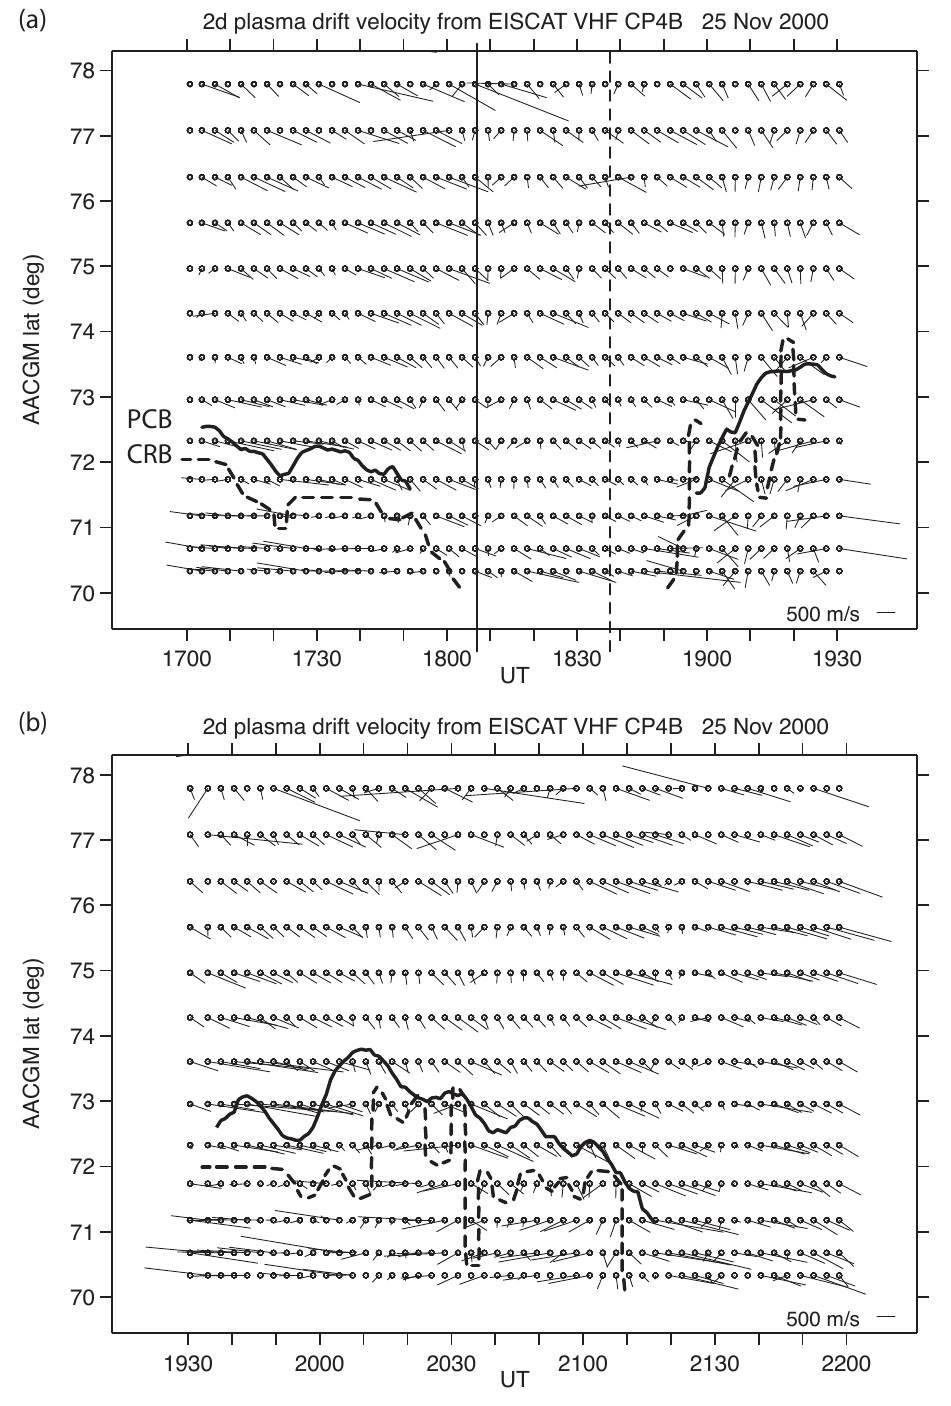
Fig. 6. Plasma drift velocity derived from the dual beam EISCAT VHF data. Only every third 1-min velocity measurement is plotted. The black solid curve indicates the 5-min running mean of the VHF polar cap boundary. The dashed curve is the plasma convection reversal boundary determined from the plasma velocity vectors. The vertical solid line at 18:07UT indicates the substorm onset occuring at about 2h MLT east of EISCAT ( ∼ 22:40MLT) and the dashed line 31min later the substorm expansion in association with the Harang discontinuity region to the EISCAT